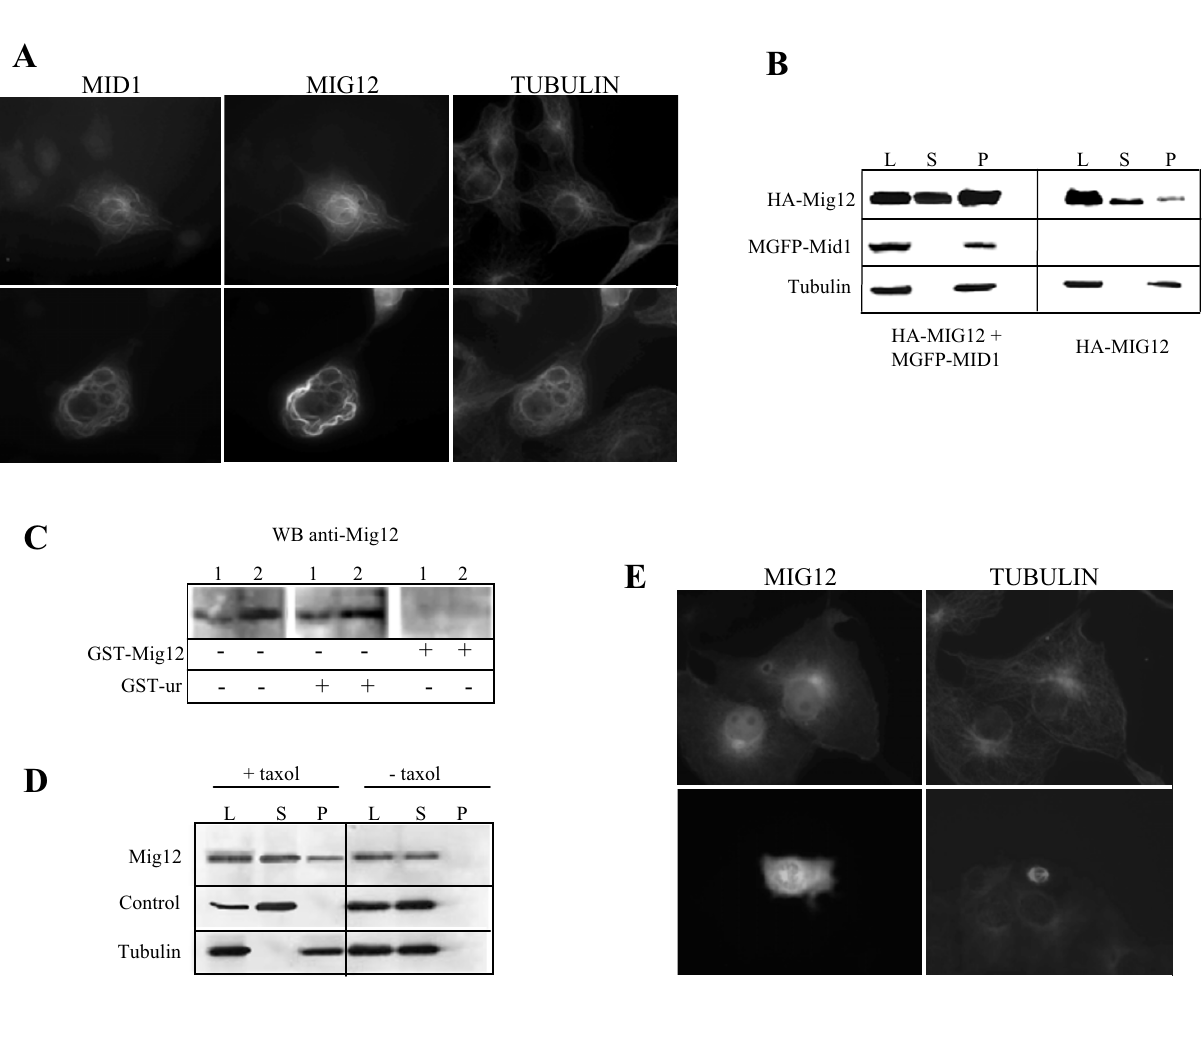
Figure 4 Mid1 and Mig12 co-sediment with microtubules. ( A ) Immunofluorescence analysis in Cos7 cells co-transfected with HA-Mid1 (left panels) and MGFPMig12 (middle panel) proteins. Coincidence of the bundles with microtubules is revealed using mono- clonal antibodies against β -tubulin (right panel). These images show the different thickness and distribution of the bundles. ( B ) Cos7 cells were transfected with either MGFPMid and HA-Mig12 (left panel) or HA-Mig12 alone (right panel). Lysates (L) from cells were supplemented with 40 µ M taxol to stabilize polymerized microtubules. After sedimentation on sucrose cushion, supernatant (S) and pellet (P) fractions were assayed for the presence of Mid1, Mig12, and tubulin using appropriate antibodies. In the co-transfection (left panel) both Mid1 and Mig12 were detected in the pellet together with the polymerized microtu- bules. As expected Mig12 is also present in the soluble fraction where neither Mid1 nor the tubulin are found. Mig12 is found partially associated with the polymerized tubulin fraction also in the single HA-Mig12 transfected cells (right panel). ( C ) West- ern blot analysis using the anti-Mig12 antibody reveals a 24 KDa protein in two different cell lines lysates (1, Cos7; 2, HeLa cells). To confirm specificity, incubation with the primary antibody was also performed in the presence of either the fusion pro- tein used to immunize rabbits (GST-Mig12) or an unrelated fusion protein (GST-ur). ( D ) Detection of endogenous Mig12 in the polymerized microtubule fraction (+ taxol) in HeLa cells and as control in the non-treated sample (-taxol); legend as in (A). ( E ) Single Mig12 transfected Cos7 cells show partial localization with microtubules, particularly in the MTOC region (upper panels) and at the mitotic spindle poles (lower